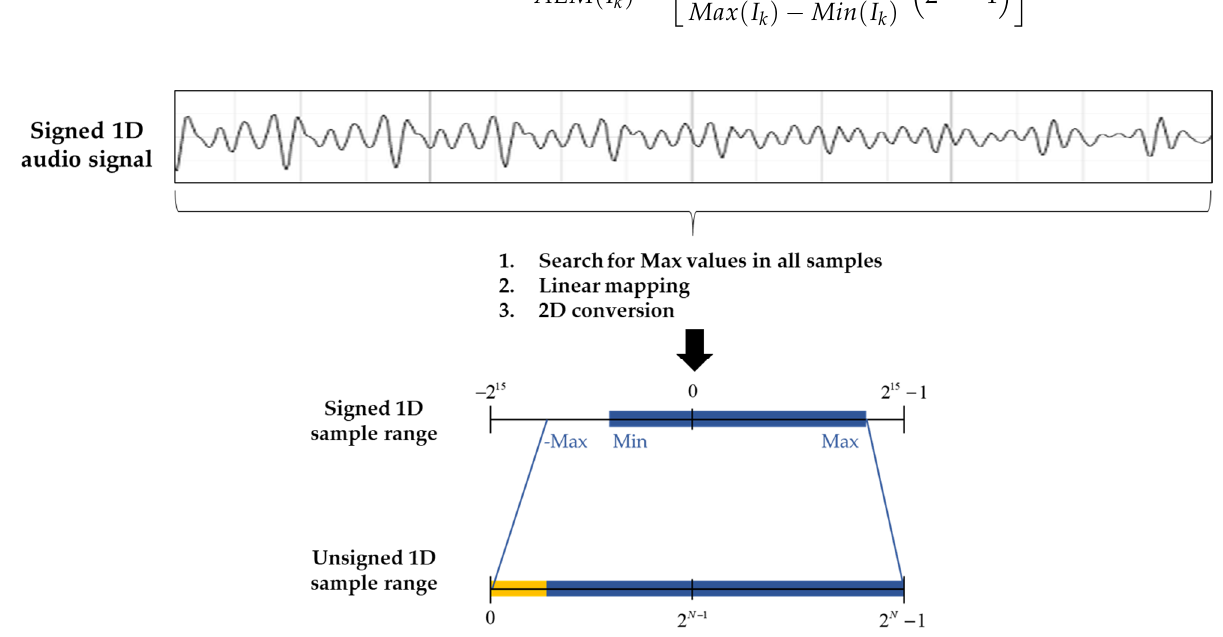
Figure 4. Graphical representation of linear mapping where the orange area indicates the unused sample range called the dead zone.